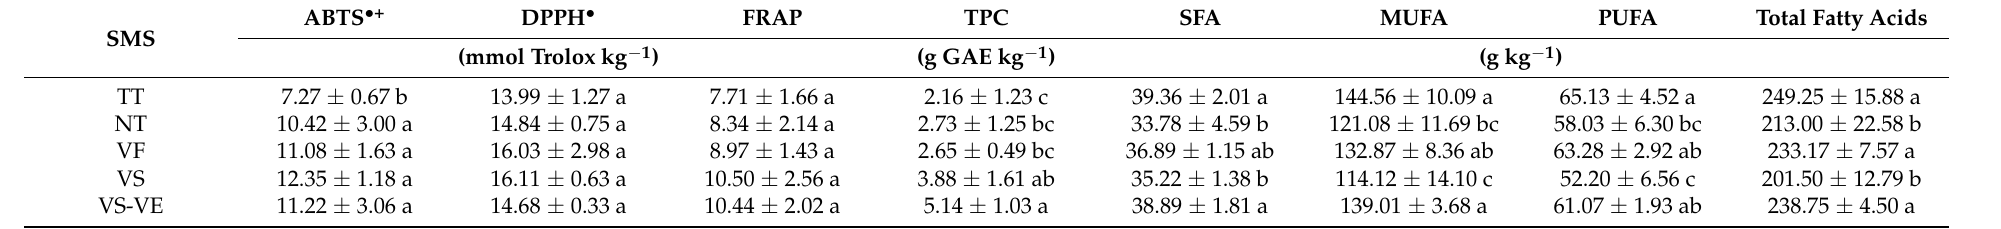
Table 9. Impact of soil management strategies on the antioxidant activity, total phenolic content, and fatty acids of almonds cv. Marcona.